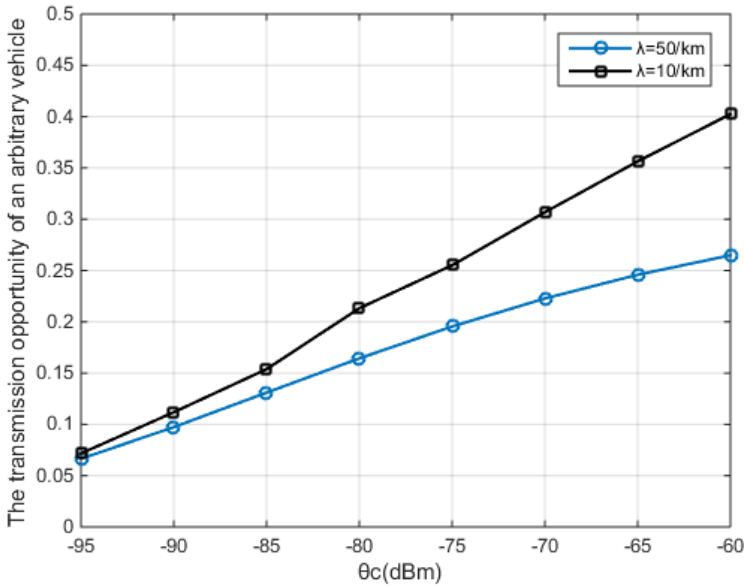
Figure 8. The transmission opportunity with highest priority versus maximum received beacon power threshold.